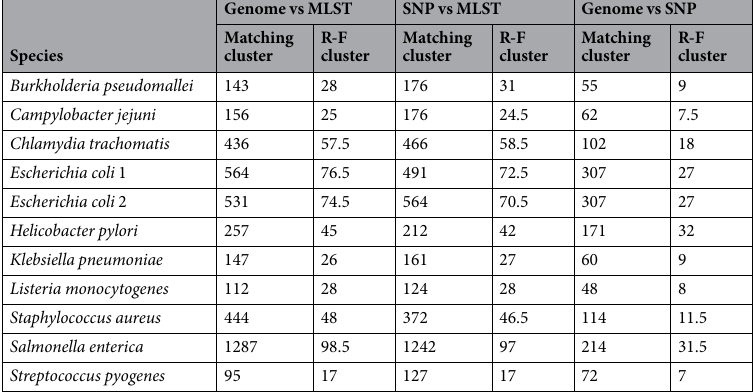
Table 3. Tree distances among phylogenies inferred using different approaches.